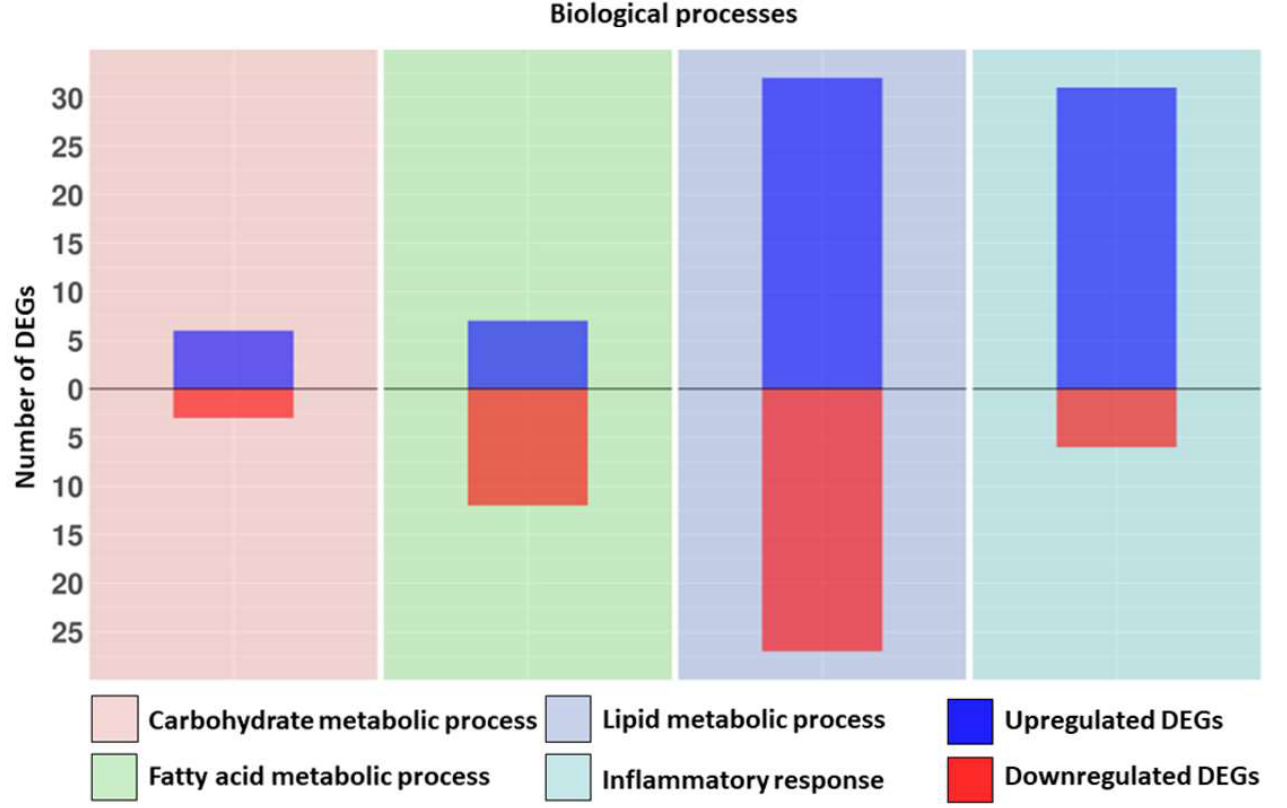
Figure 1. Bar plot distributions of Differentially expressed genes (DEGs) related to the “Carbohydrate metabolic process”, “Fatty acid metabolic process”, “Lipid metabolic process” and “Inflammatory response”. Blue indicates the upregulated DEGs, and red indicates the downregulated DEGs for each biological process. The figure is split into four sections, one for each biological process.